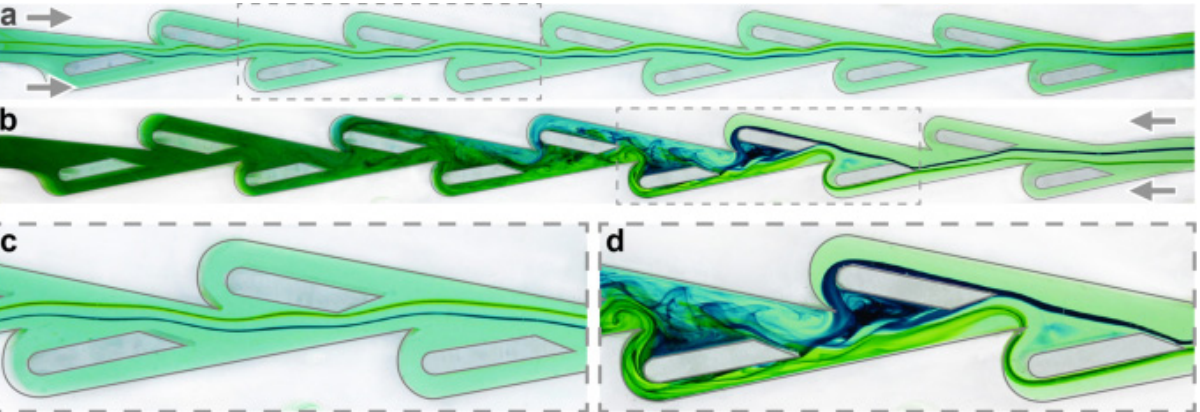
Figure 1. TV structure, visualized with green dye solutions in forward ( a , c ) and reverse ( b , d ) direc- tions with a Reynolds number ( Re ) around 200. The flow is undisturbed in the forward direction ( a , c ). In the reverse direction, the flow resistance and mixing are predominant ( b , d ). Reprinted from [9] under the Creative Commons license.